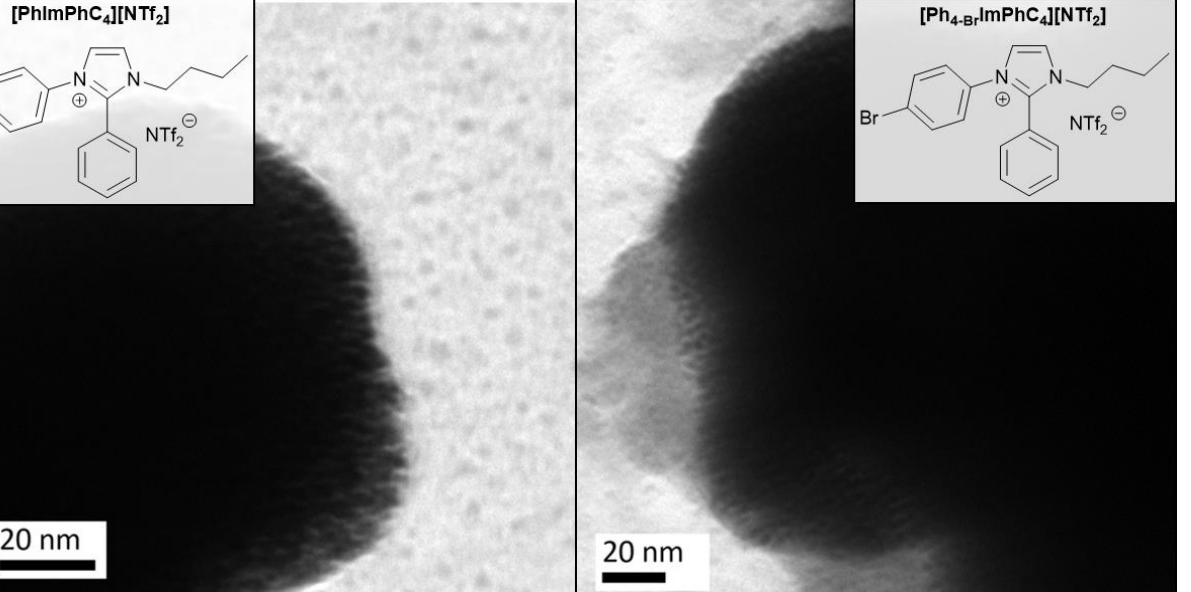
Figure 6. TEM images of (EG/TAAIL)Pt-NPs obtained in [PhImPhC 4 ][NTf 2 ] (PP4) and [Ph 4-Br Im- PhC 4 ][NTf 2 ] (BPP4), respectively. TEM images of the other samples can be found in Figures S25 to S33. Table 3. Summary of crystallite and particle sizes of